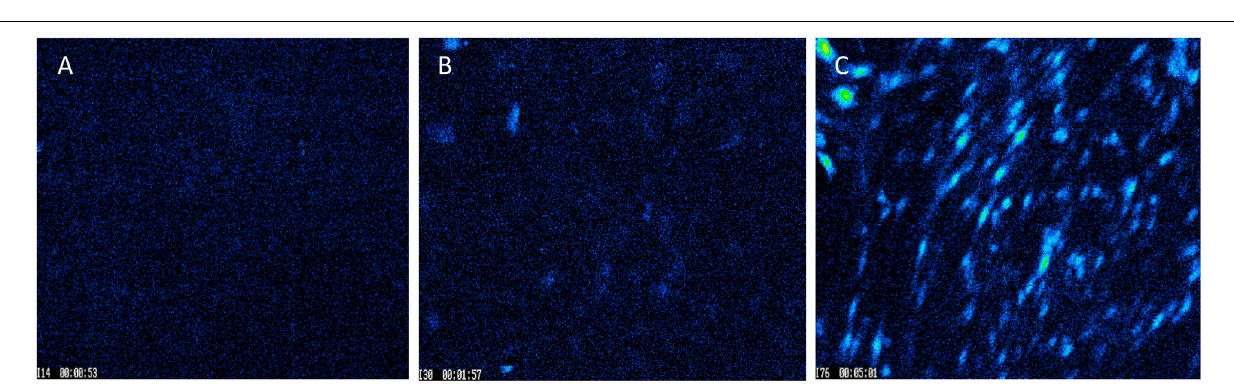
FIGURE 6 | Images captured for BMVECs during Ca 2 + treatment: (A) before stimulation; (B) peak stimulation by 50 µ g/mL of empty halloysite nanotube, and (C) peak stimulation by 50 µ g/mL nanotubes loaded with ionomycin. Magnification =